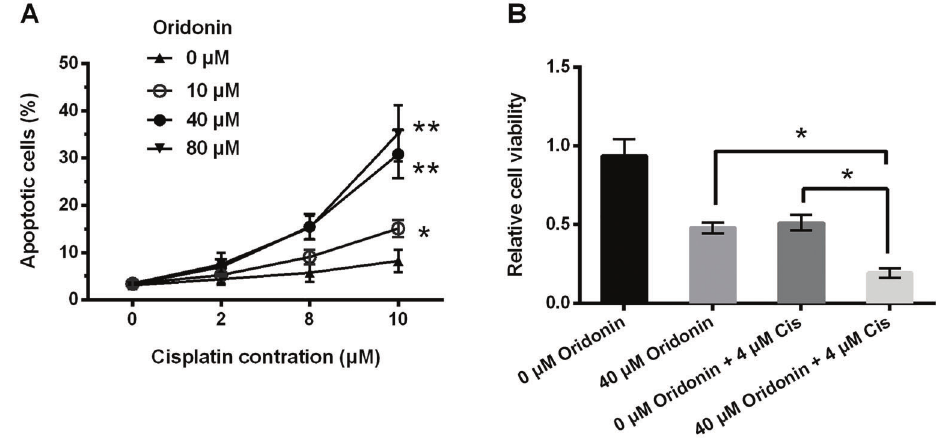
Figure 3. Oridonin synergized the effect of cisplatin in SNU-216 cells. SNU-216 cells were treated with oridonin combining with or without cisplatin for 24 h. A , percentage of apoptotic cells and B , cell viability were assessed by fl ow cytometry assay and CCK-8 assay, respectively. Cis, cisplatin. Data are reported as means ± SD. *P o 0.05, **P o 0.01